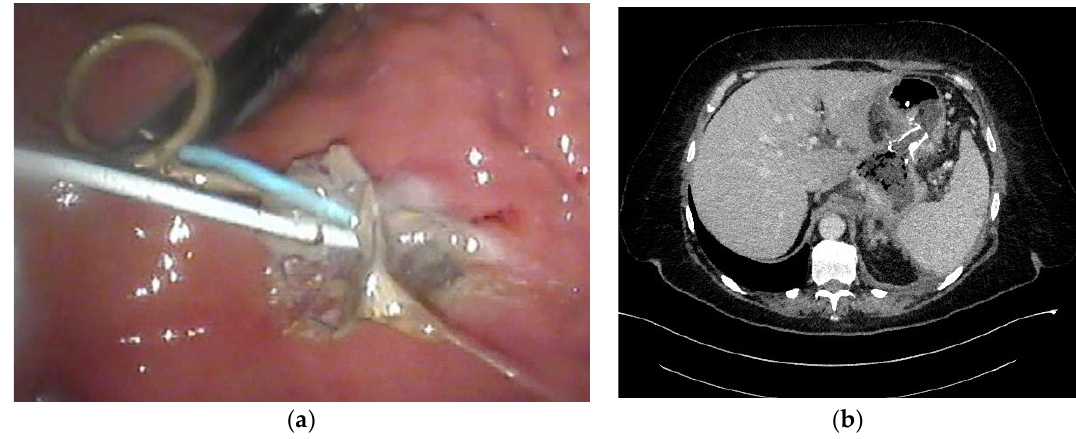
Figure 6. ( a , b ), SEMS in endoscopic transmural drainage of pancreatic necrosis. Two plastic stents and a nasocystic catheter were inserted into the WOPN through the metallic stent. Thick necrotic content is draining through the metal stent. SEMS, self-expanding metallic stent; WOPN, walled-off pancreatic necrosis.